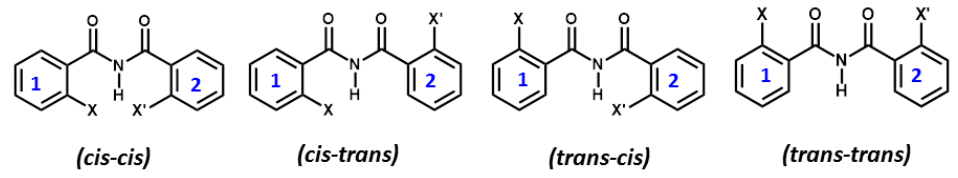
Figure 30. The possible conformers of the investigated imide molecules, arising due to the ring flip. Out of the four possible conformers the cis-cis and trans-trans conformers were optimized and the difference {( cis-cis ) – ( trans-trans )} of minimum energy has been taken. The energy difference Δ E cis-trans varied from approximately − 2 to − 11 Kcal/mol among all the investigated imide molecules and it is also found that the energy of cis-cis conformers is always lower than the trans-trans that are due to the presence of HB.